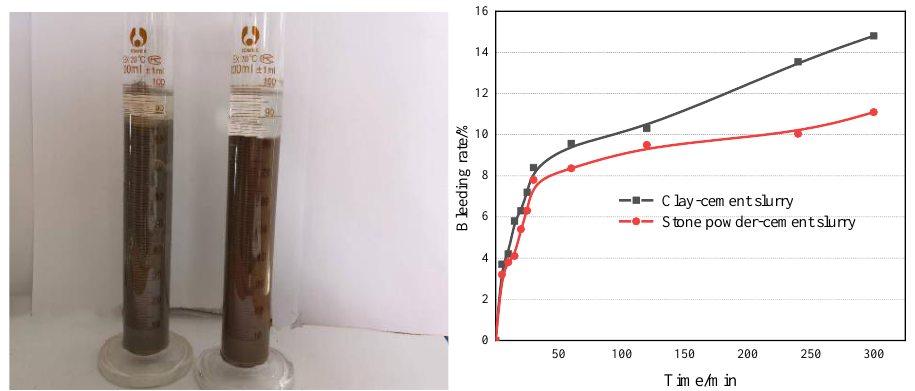
Figure 8. Bleeding rate test of clay cement and stone powder cement slurry.